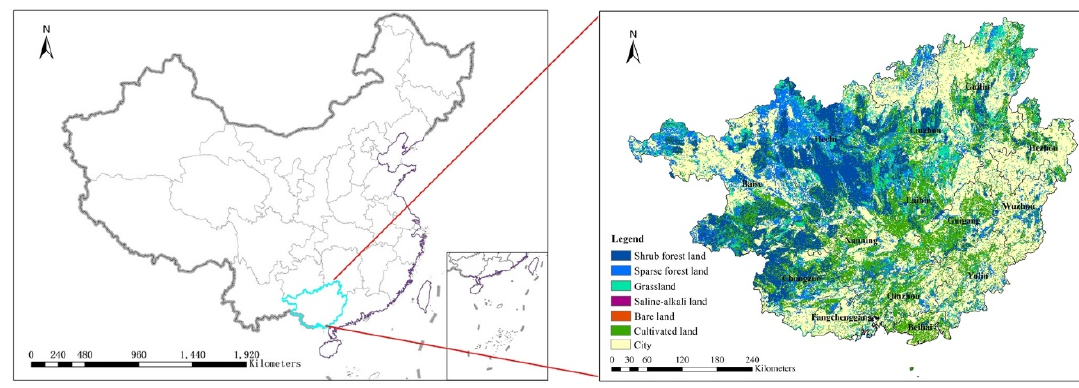
Figure 2. Geographical location and land cover distribution of the Guangxi Zhuang Autonomous